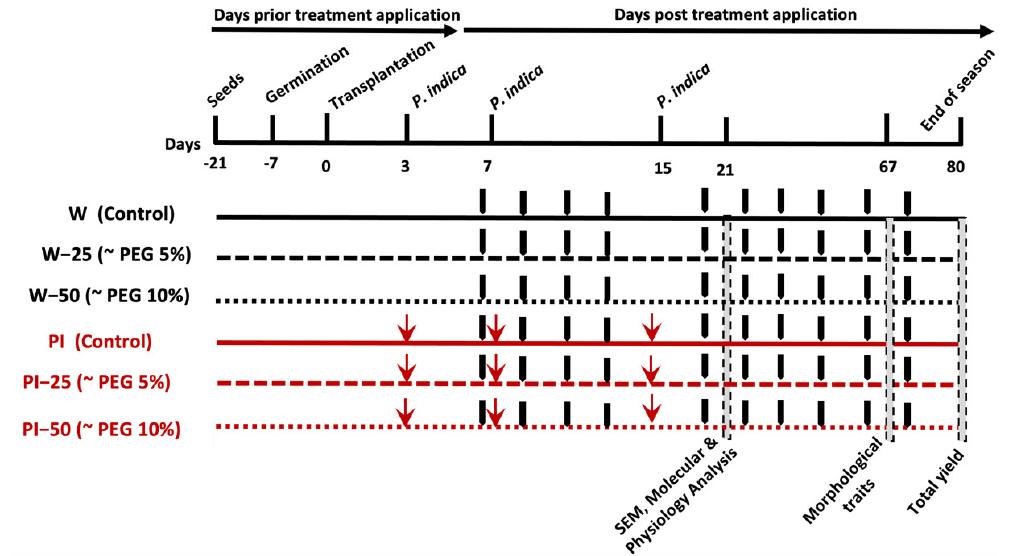
Figure 1. Scheme of the experimental setup. Horizontal lines characterize different plant treatments as follow: W (normal irrigation), W-25 (moderate water stress; equal 25% less than normal irrigation; equivalent to PEG 5%), W-50 (severe water stress; equal 50% less than normal irrigation; equivalent to PEG 10%), PI (inoculation with P. indica under normal irrigation), PI-25 (inoculation with P. indica under 25% less than normal irrigation; equivalent to PEG 5%), and PI-50 (inoculation with P. indica under 50% less than normal irrigation; equivalent to PEG 10%).